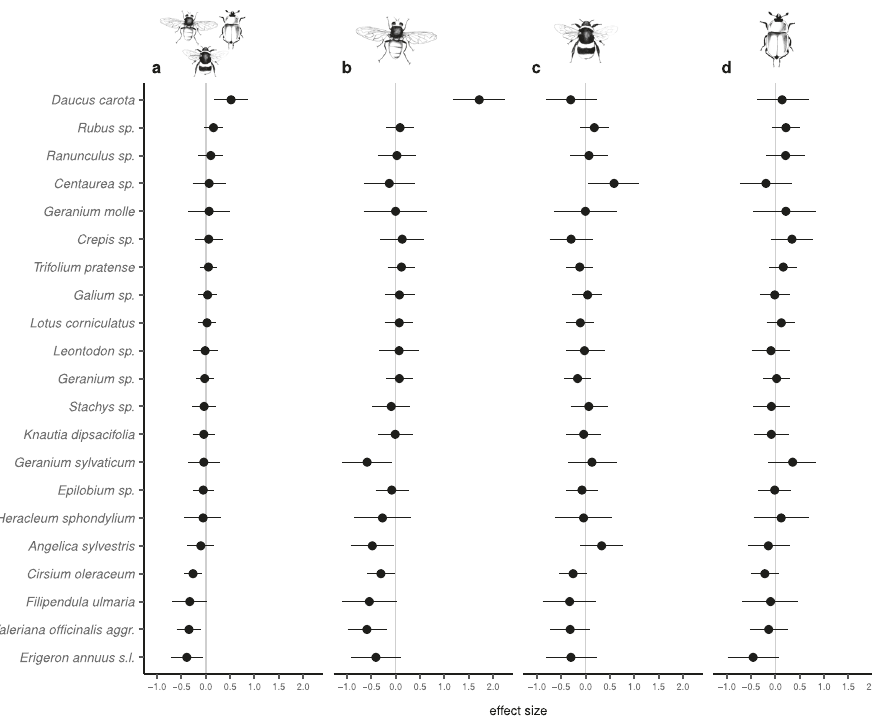
Fig. 1 Effect of arti fi cial light at night on diurnal plant – pollinator interactions. Plant-speci fi c estimated effects (median ± 95% credible interval, computed from the marginal posterior distribution of the model parameters) of the light treatment on the total number of plant – pollinator interactions ( a all insect groups together), and separate for the different insect groups ( b Diptera, c Hymenoptera, d Coleoptera). As the response variable was log-transformed to ful fi ll the model assumptions (Gaussian error distribution), the back transformed number of interactions at lit sites equals to the number of interactions at unlit sites × exp(effect size). For example, an average of 10 interactions at unlit sites with an effect size of − 1 translates in 10 × exp( − 1) interactions at lit sites (i.e., 3.68